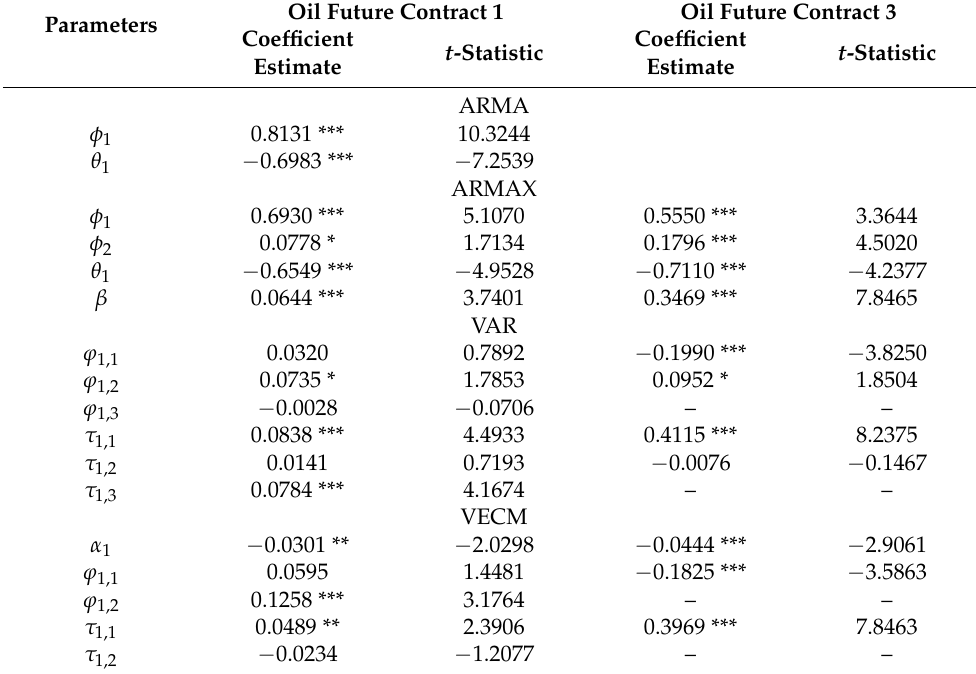
Table 5. Estimated results (MGO in